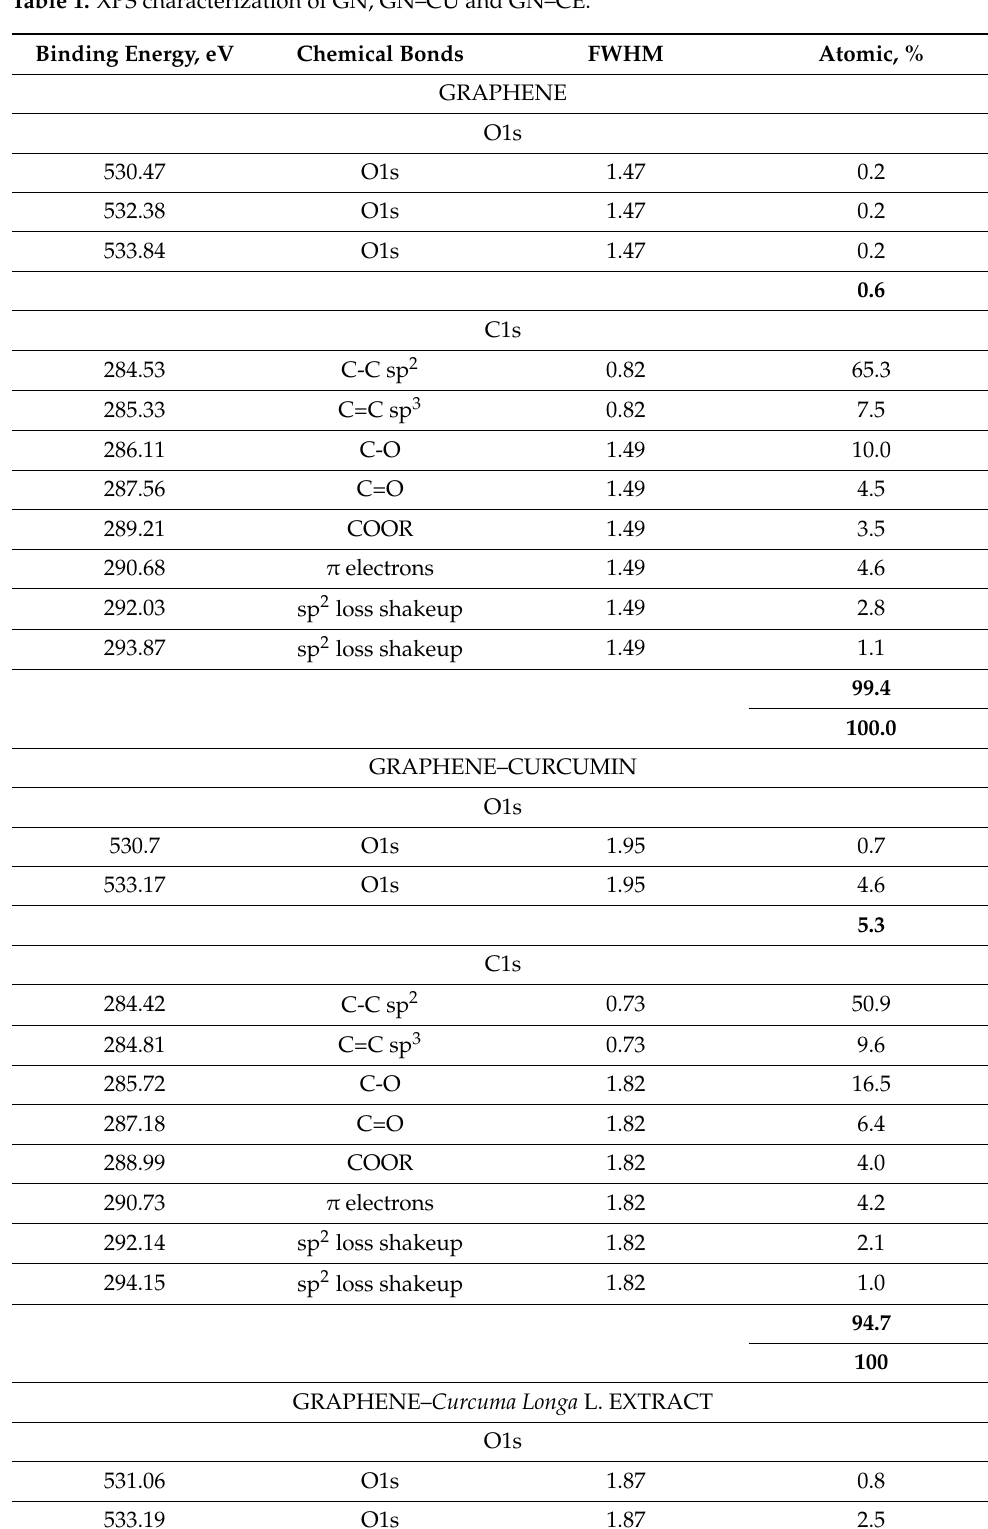
Table 1. XPS characterization of GN, GN–CU and